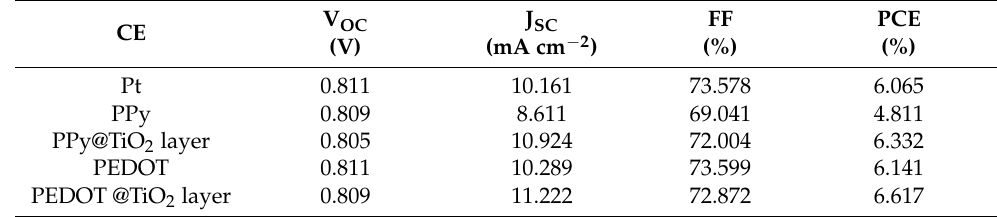
Table 3. Photovoltaic parameters of DSSCs with various CEs and [Co(bpy) 3 ] 2+/3+ redox